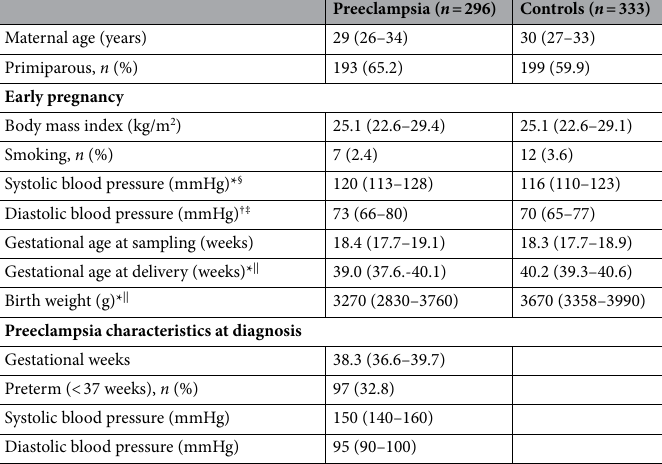
Table 1. Clinical characteristics of women in the study by development of preeclampsia. Data are given as medians (interquartile range) for continuous variables and frequency (%) for non-continuous variables. Differences between groups were tested with the Mann–Whitney U test or the Pearson’s chi-squared test, * p ≤ 0.001, † p ≤ 0.01. Data are missing for three ( ‡ ), two ( § ), or one ( || ) participants.